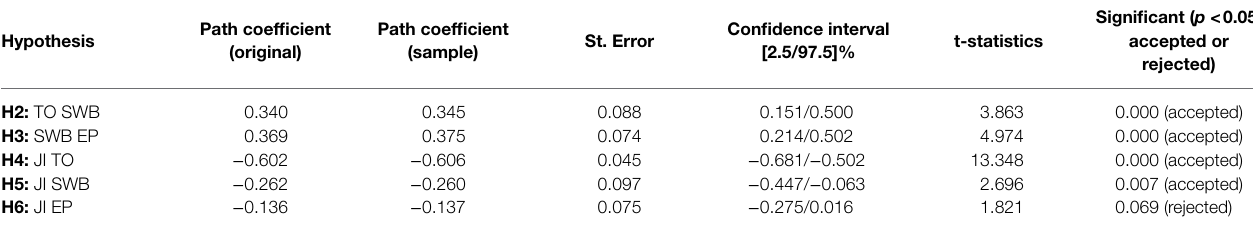
TABLE 5 | Hypotheses